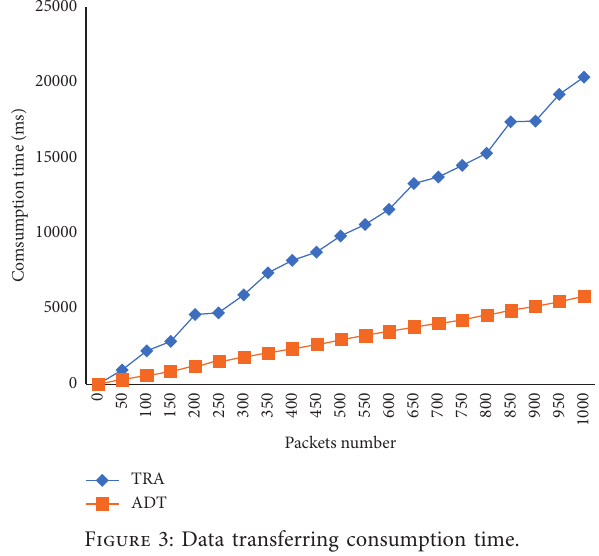
Figure 3: Data transferring consumption time.